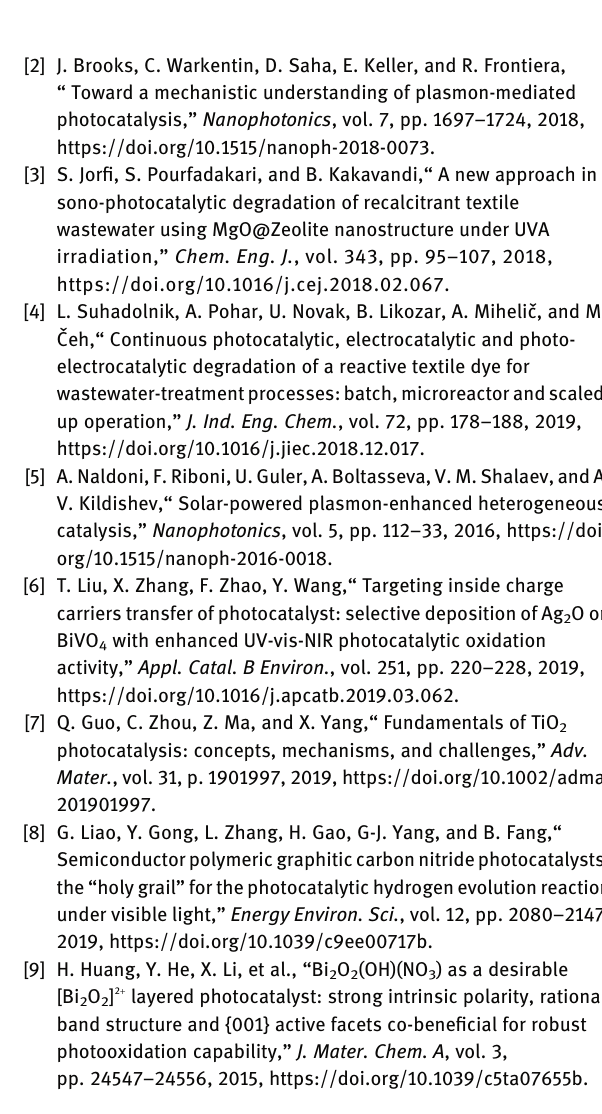
Figure 7: Schematic diagram of photocatalytic mechanism of C-TiO 2 /Bi 4 NbO 8 Cl composites (a) before contact, (b) after contact and (c) upon